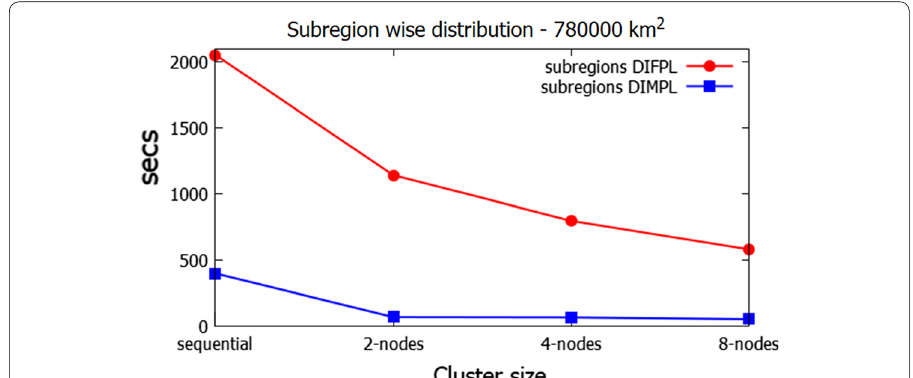
Fig. 19 Performance of subregion wise distribution in MapReduce and Spark for various sized clusters and a larger